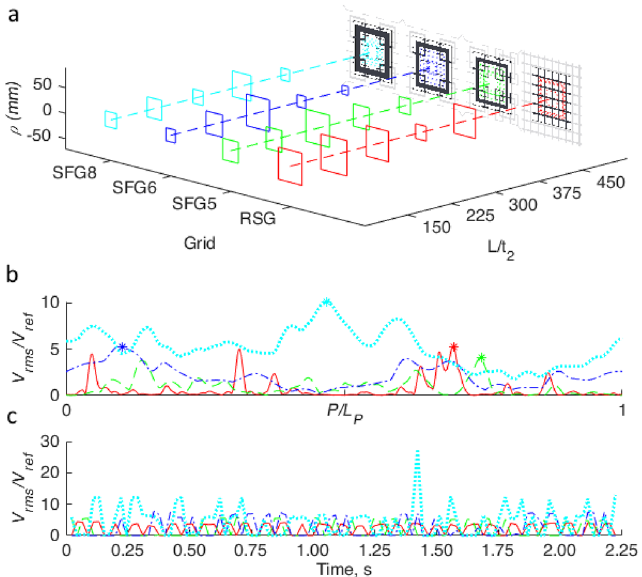
Figure 5. ( a ) Concentric square, ρ with the largest ρ averaged V rms for each grid at each streamwise distance L/t 2 . ( b ) Normalized V rms profile of maximum concentric square at L/t 2 = 150, with maximum point indicated by asterisk. ( c ) Normalized V rms time-series of the corresponding maximal in ( b ). (note: prepared in Matlab R2018A, https:// www. mathw orks. com/ produ cts/ matlab.